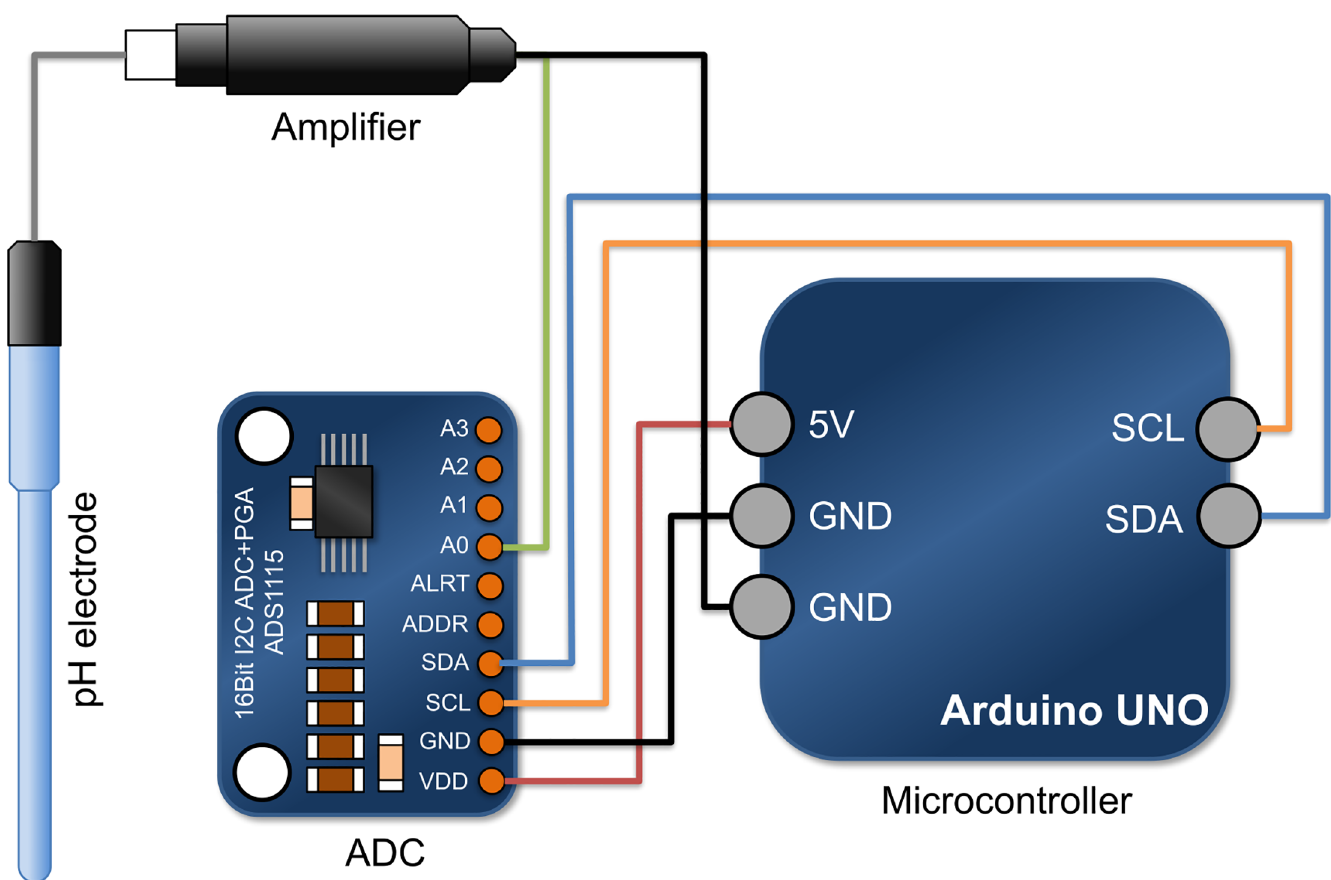
Fig 1. The pHOS apparatus for pH calibration, measurement and data logging. The configuration of nodes on the Arduino UNO controller was simplified to highlight the circuit connections. To improve the precision of pH measurement, the Arduino micro-controller must be plugged in with an independent power supply to avoid reference voltage fluctuation when powered only by the USB